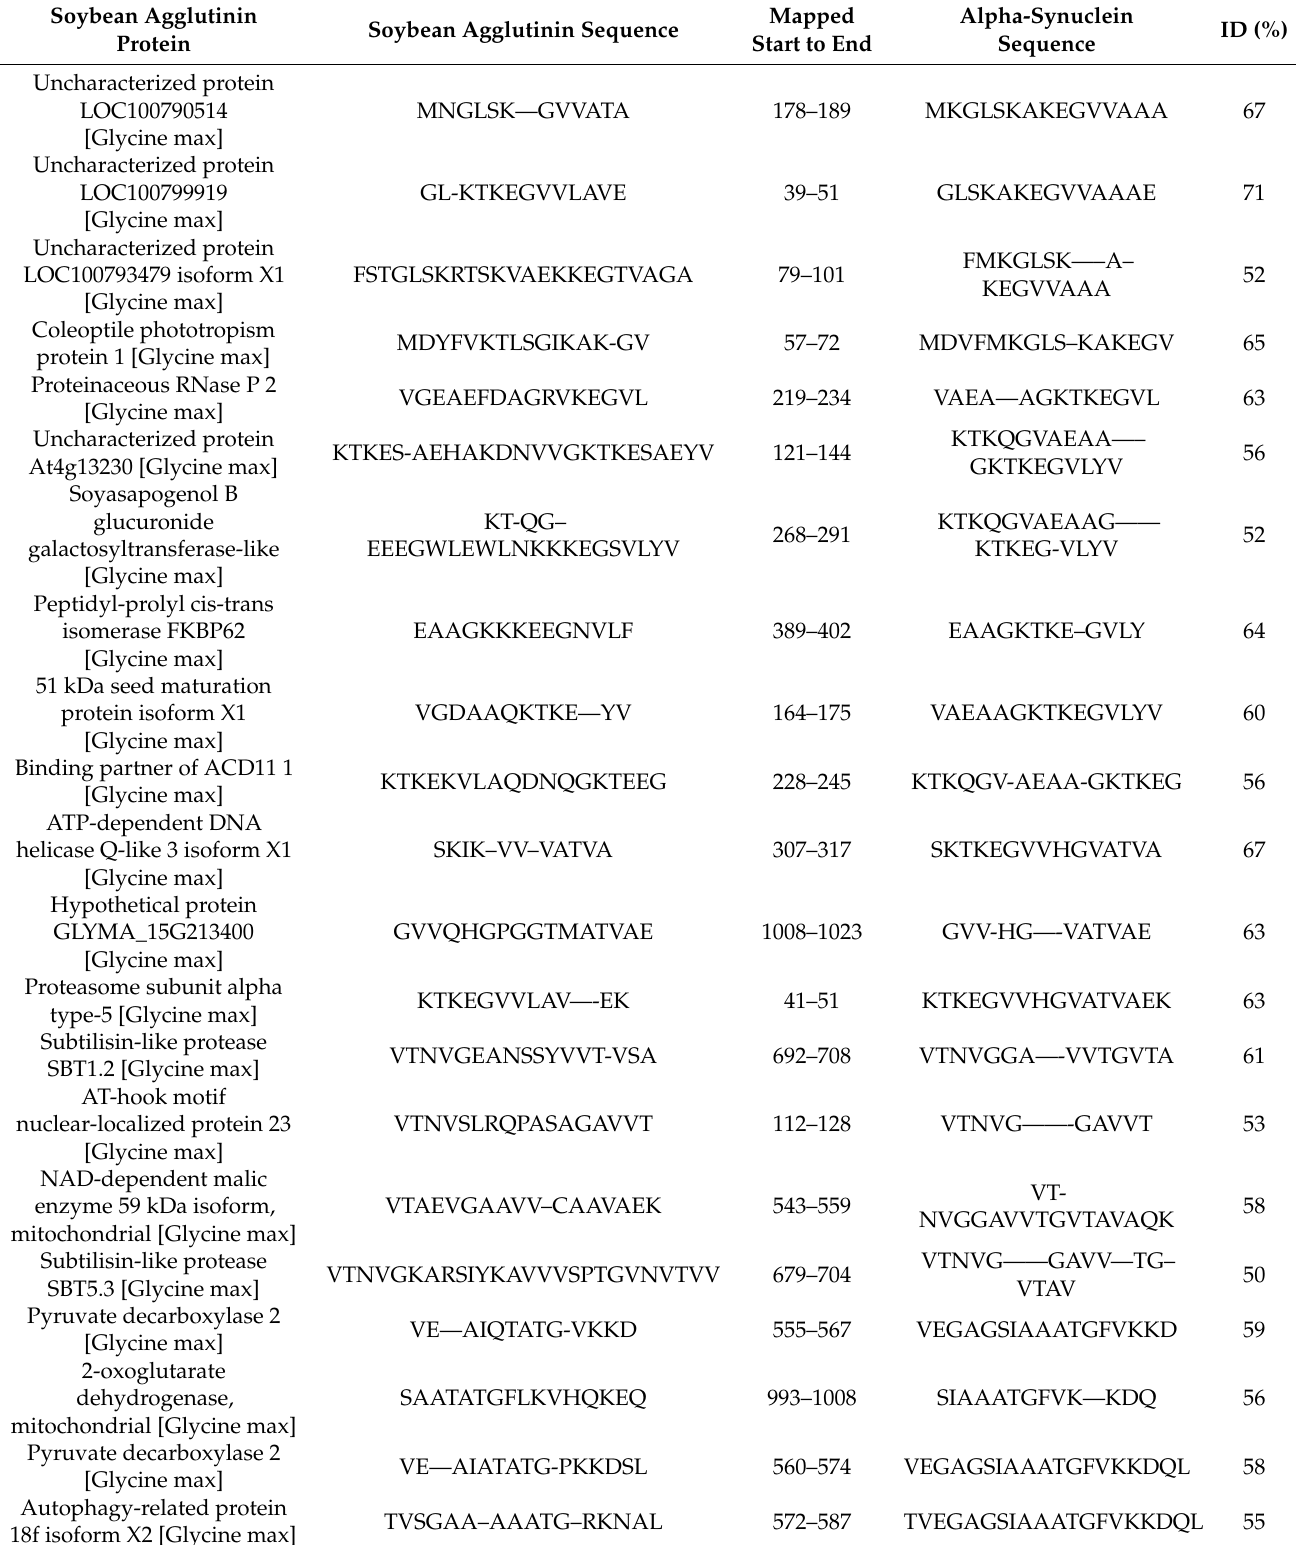
Table 2. Potential cross-reactive epitopes between alpha-synuclein proteins and soybean agglutinin proteins. Soybean Agglutinin Soybean Agglutinin Sequence Protein